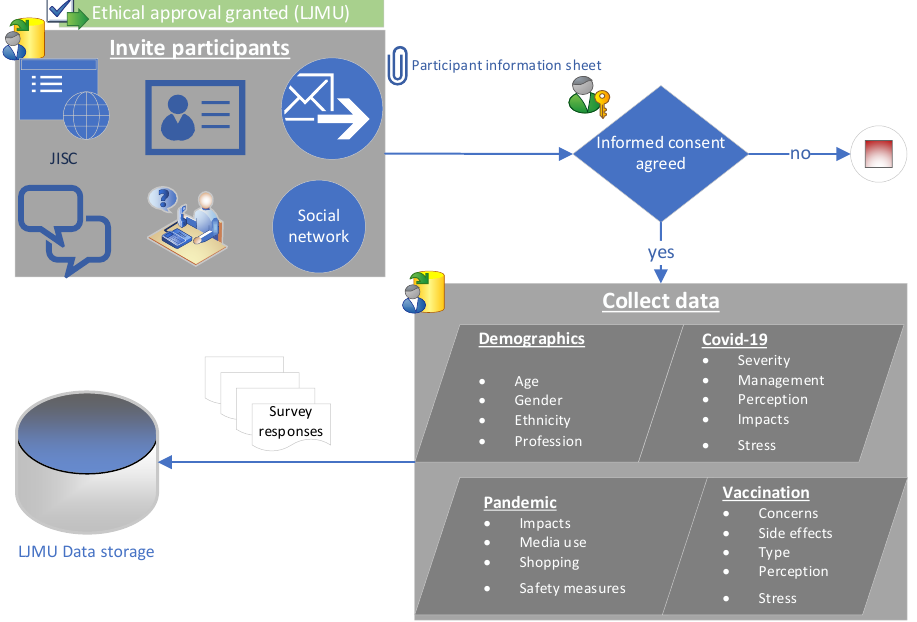
Figure 2. Sequential procedure for primary data collection, ethical process, survey contents, and information storage.